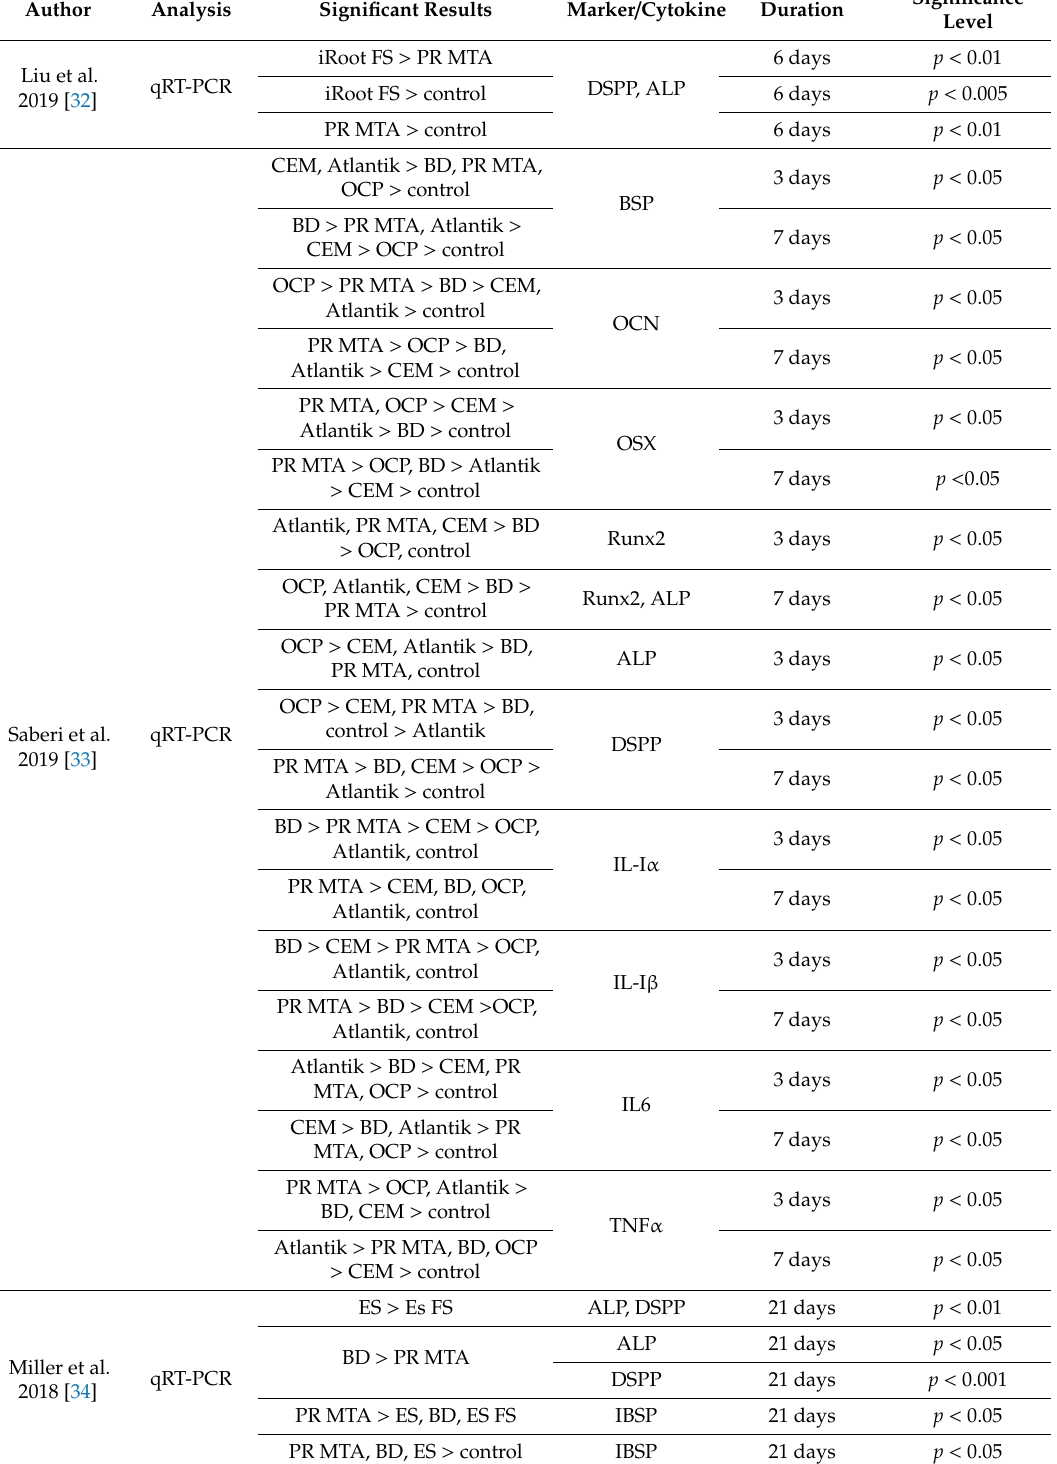
Table 5. Summary of the results of included studies showing significant di ff erences between bioceramic materials or a bioceramic material and a control for hSCAP activity-related marker